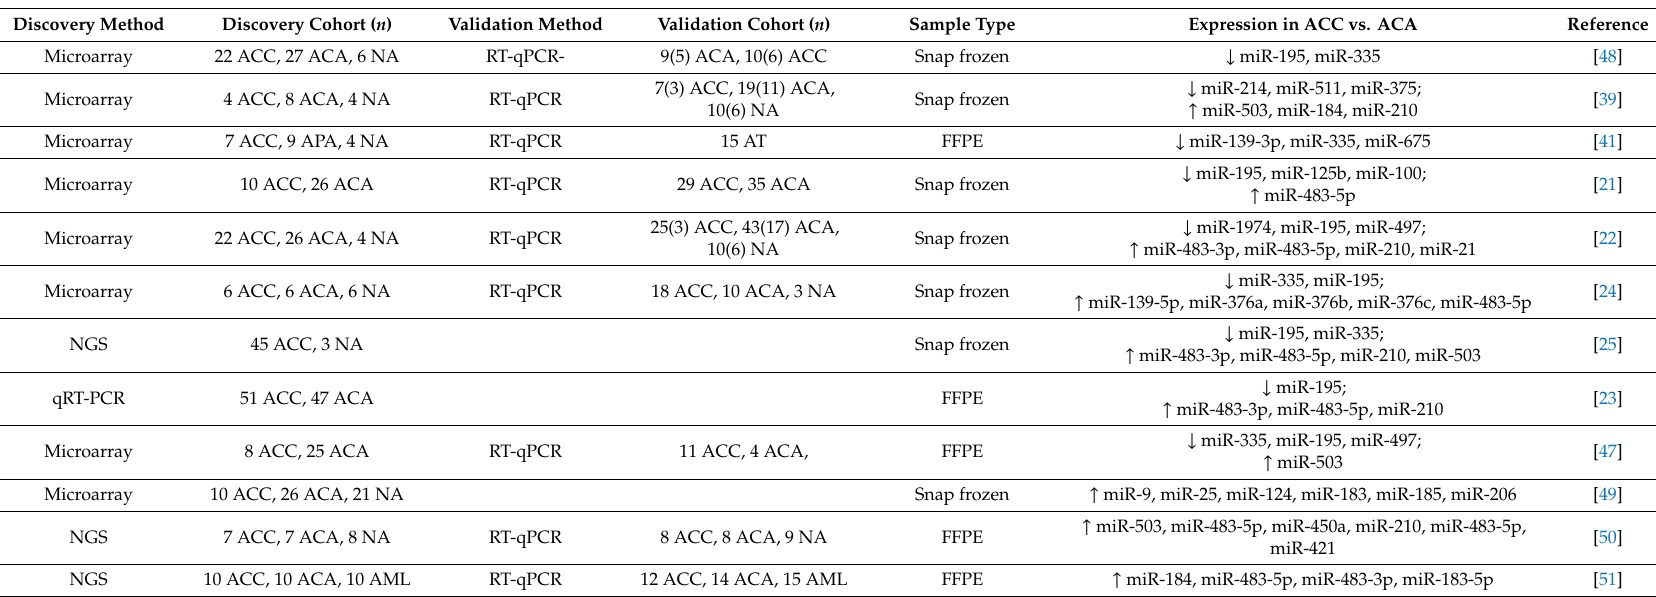
Table 1. Studies on tissue miRNA expression profiling in ACC and